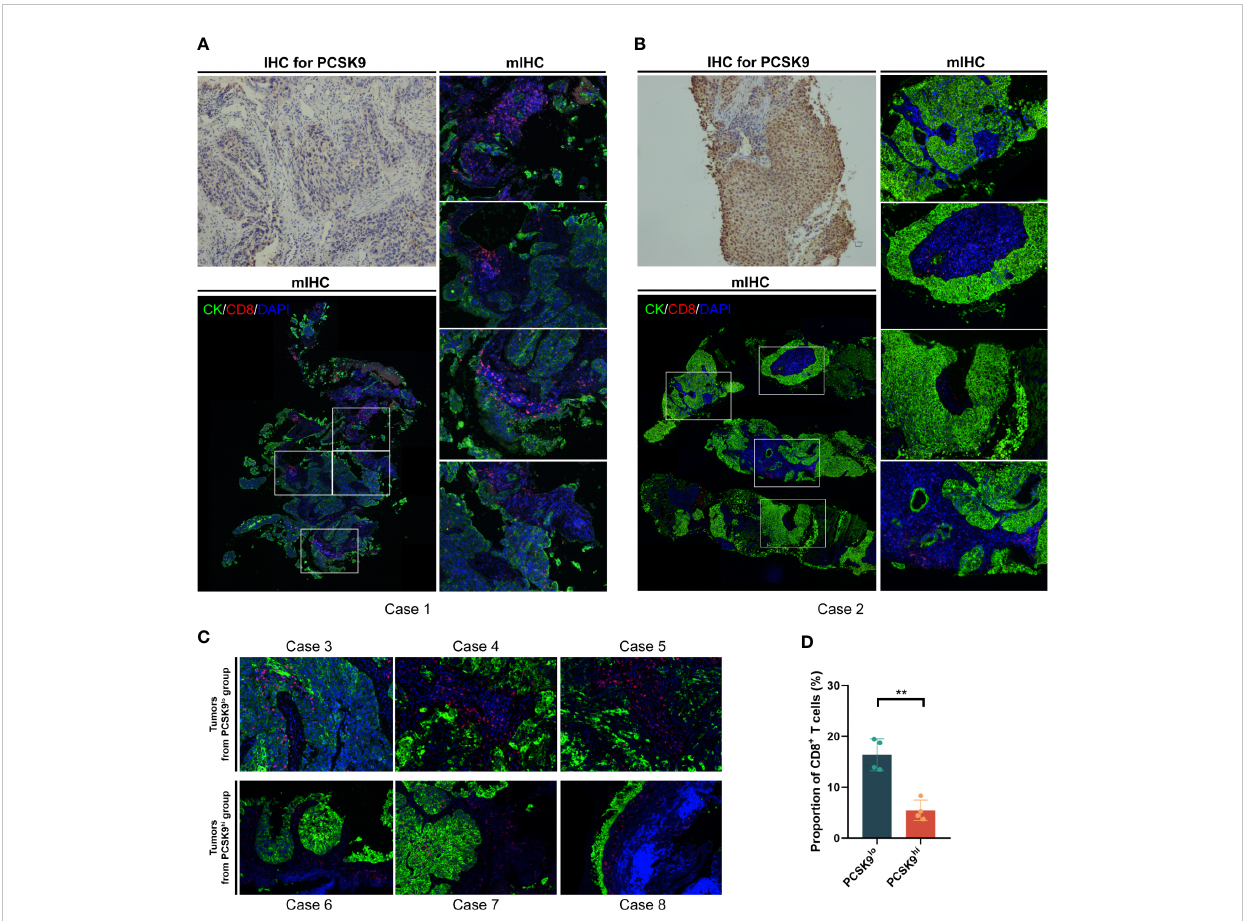
FIGURE 3 CD8 + T cells increased and moved into the tumor-cell-rich areas in PCSK9 lo tissue, while they stayed in the margin of tumor areas in PCSK9 hi tissue. (A, B) Multiplexed immuno fl uorescent staining of CK, CD8, and DAPI in the tumor microenvironment (bottom left panel and right panel, ×200 original magni fi cation) of PCSK9 lo (A) or PCSK9 hi (B) tissue adjudicated by immunohistochemistry (upper left panel, ×200 magni fi cation). (C) Typical views of other tumors from the PCSK9 lo or PCSK9 hi groups (×200 magni fi cation). (D) Quantitative estimates of the density of CD8 + T cells: proportion of CD8 = CD8 number/DAPI number. **P <